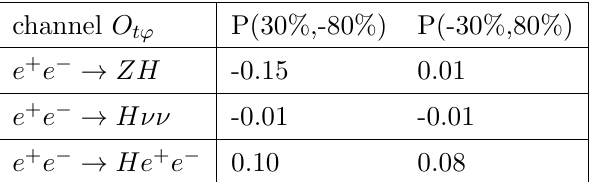
Table 5 . Percentage deviation (cid:22) ij for production channel i and operator O t’ for 350 GeV and P ( e + ; e (cid:0) ) = ( 30% ; 80%). The results are identical at any (cid:22) EFT (cid:6) (cid:7)